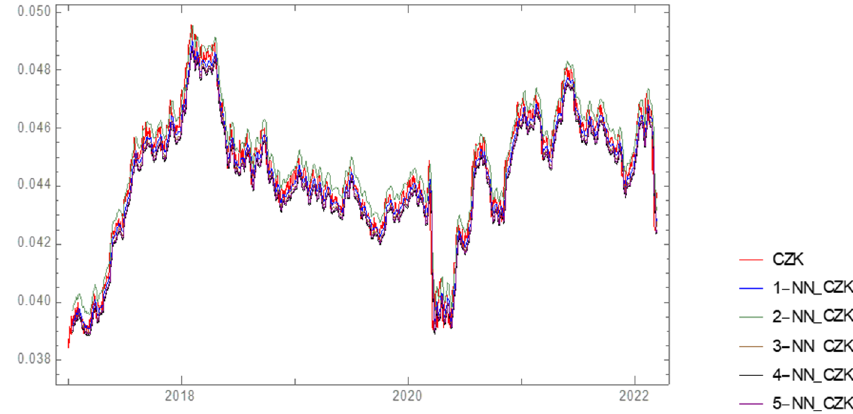
Figure 9. The current trend of smoothed time series and CZK price in USD.